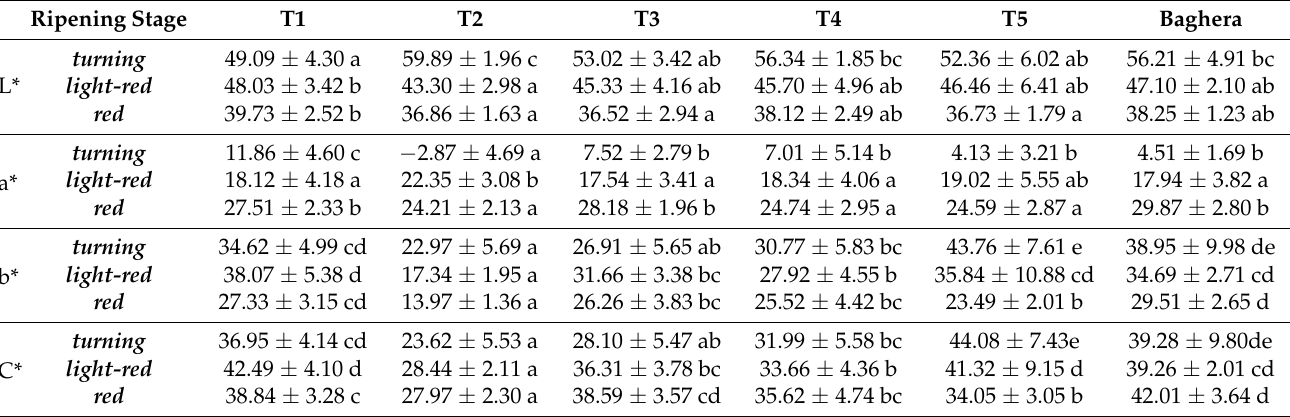
Table 3. Tomato external color parameters.